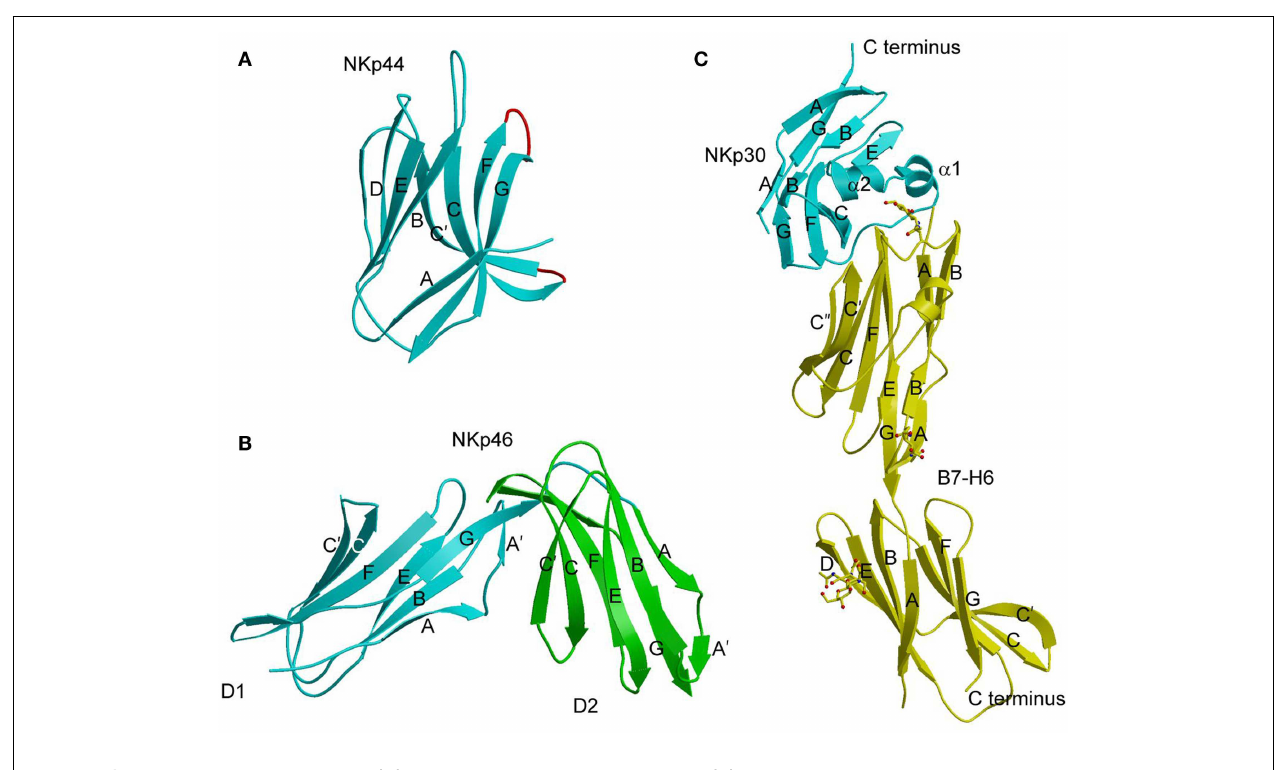
FIGURE 4 | Natural cytotoxicity receptors . (A) Structure of NKp44 (1HKF).The β -strands are labeled.The CC (cid:48) and FG loops, drawn in red, define a positively charged surface groove that may serve as a binding site for anionic ligands. (B) Structure of NKp46 (1P6F). D1 is cyan; D2 is